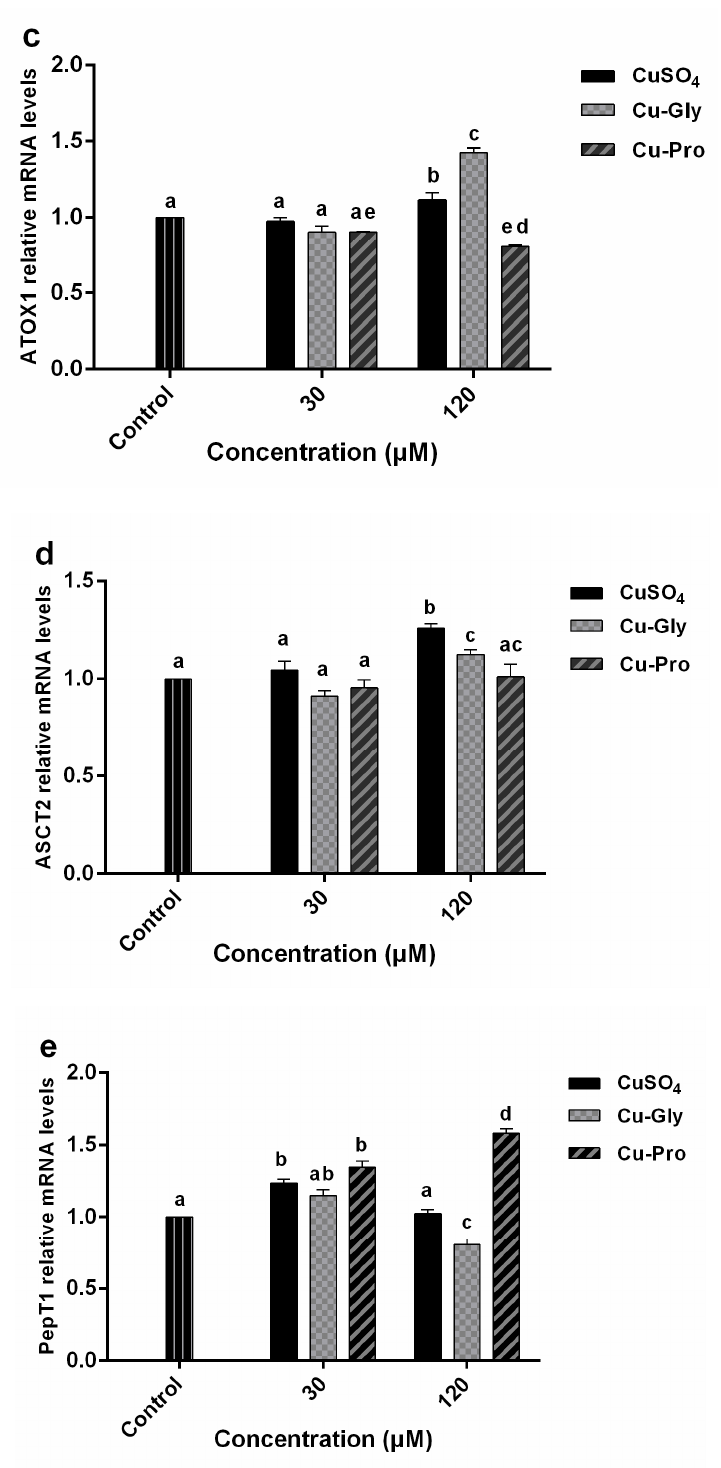
Figure 4. The relative mRNA expression levels of CTR1 ( a ), ATOX1 ( b ), ATP7A ( c ), ASCT2 ( d ), and PepT1 ( e ) in IPEC-J2 cells. Cells were treated with CuSO 4 , Cu-Gly, and Cu-Pro at the concentrations of 30 and 120 µ M for 10 h. β -actin was used as the reference gene. The results were normalized to the gene expression in control conditions. Data represent mean values ± standard deviation ( n = 3). Significant di ff erences between processing groups are represented by di ff erent lowercase letters ( p < 0.05).